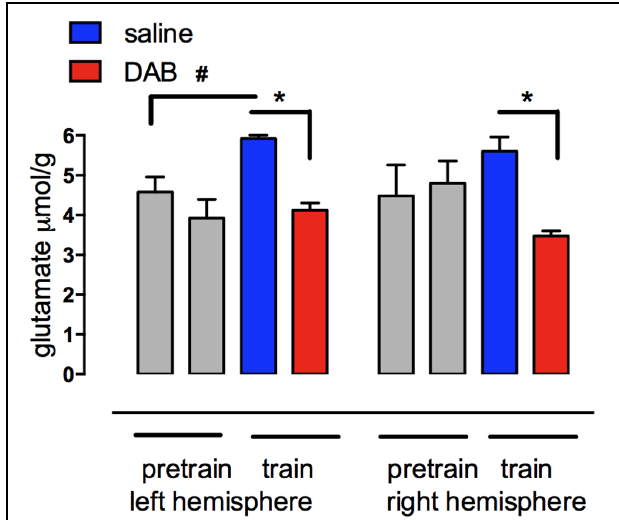
FIGURE 2 | Glutamate content measured with HPLC in left and right forebrain hemispheres of chicks before and after training in the presence of DAB or saline. Chicks were injected with either saline or DAB 5 min before strongly reinforced training and brains rapidly removed 5 min after training. The increase in glutamate in the left hemisphere is prevented by DAB. No concomitant decrease occurred in aspartate or glutamine. # , * P < 0.05. (From Gibbs et al.,